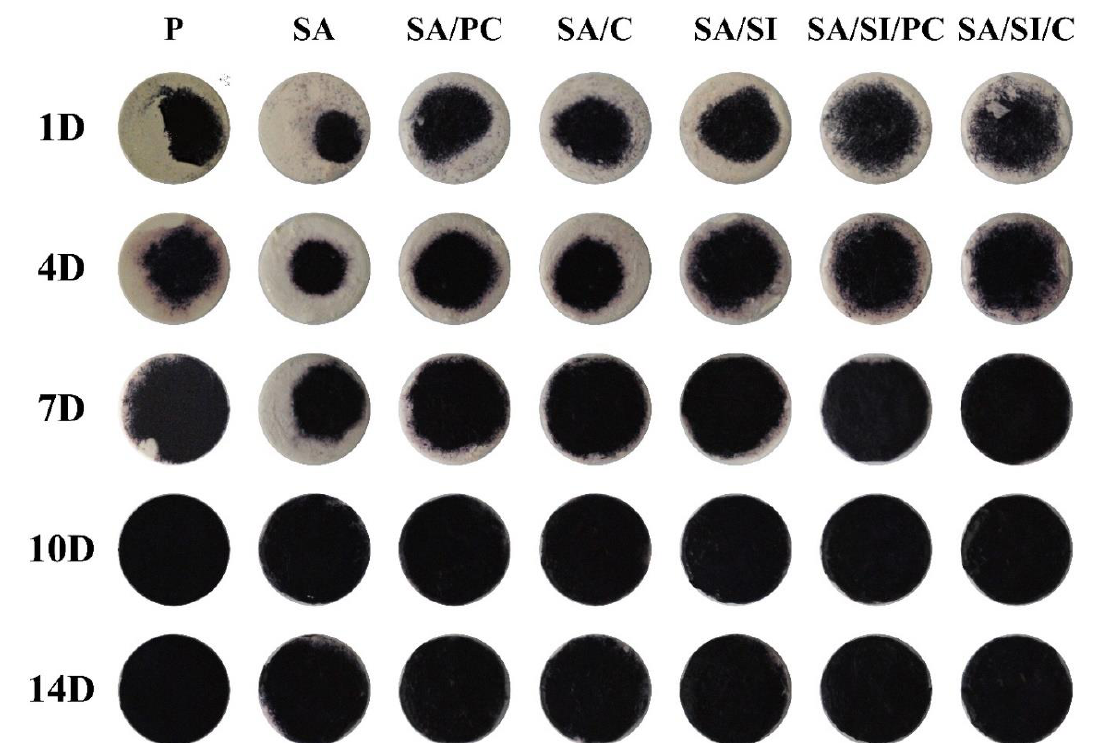
Figure 11. ALP staining results of osteo-progenitor D1 cells, which have been stained after culturing on surface-modified PEEK for 1, 4, 7, 10, and 14 days.